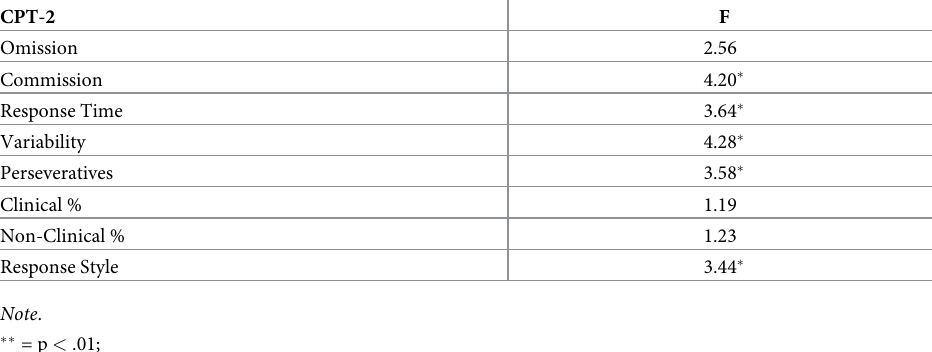
Scores on measures of commission, response time, variability, perseveratives, and response style under the CPT-2 demonstrated significant interactions between age group and metabolic status. These interactions across the CPT-2 suggest that the young and middle-aged adults with MetS made more errors (commissions, perseveratives) and were more inconsistent in their responses as compared to controls. However, the older adults with MetS had fewer errors, better response times, and more consistency as compared to healthy older adults. Across age groups, participants with MetS also had faster response times (although this does not imply accuracy). These data support the notion of relative deficits related to attention in young and middle-aged adults with MetS. They also suggest the potential for a survivor effect or protec- tive effect of MetS in older adults [35, 75, 76]. Table 6. Metabolic status by age group interactions for